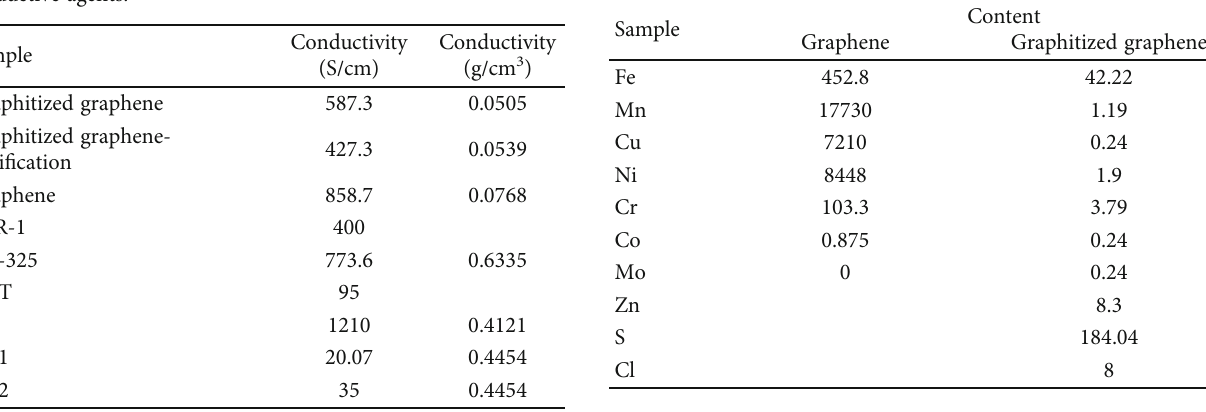
Table 2: Element content in graphene powder. Table 1: Comparison of conductivity between graphene and other